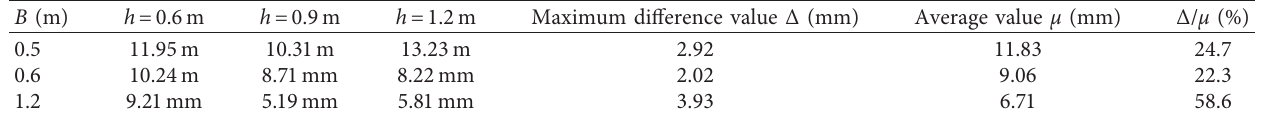
Figure 9: The variation curve of the deformation of rib pillars with the wall body at different buried depths h. (a) B � 0.5m, (b) B � 0.6m, and (c) B � 1.2 Table 6: The maximum deformation of rib pillars at different buried depths h .